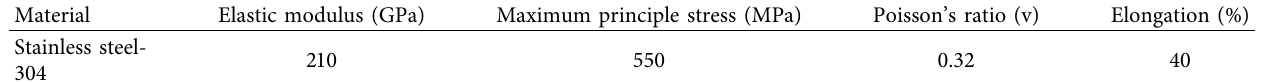
Table 2: Elastic properties of the SS-304 used.